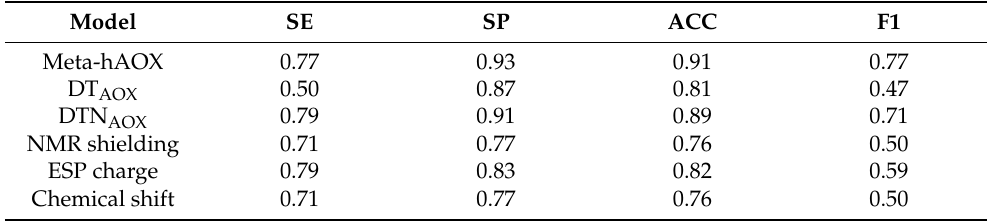
Table 5. The performance of our model (Meta-hAOX) on the external data set collected by Zhao et al., compared with the DT AOX model, DTN AOX , and three descriptors proposed by Montefiori et al. Model SE SP ACC F1 Meta-hAOX 0.77 0.93 0.91 0.77 DT AOX 0.50 0.87 0.81 0.47 DTN AOX 0.79 0.91 0.89